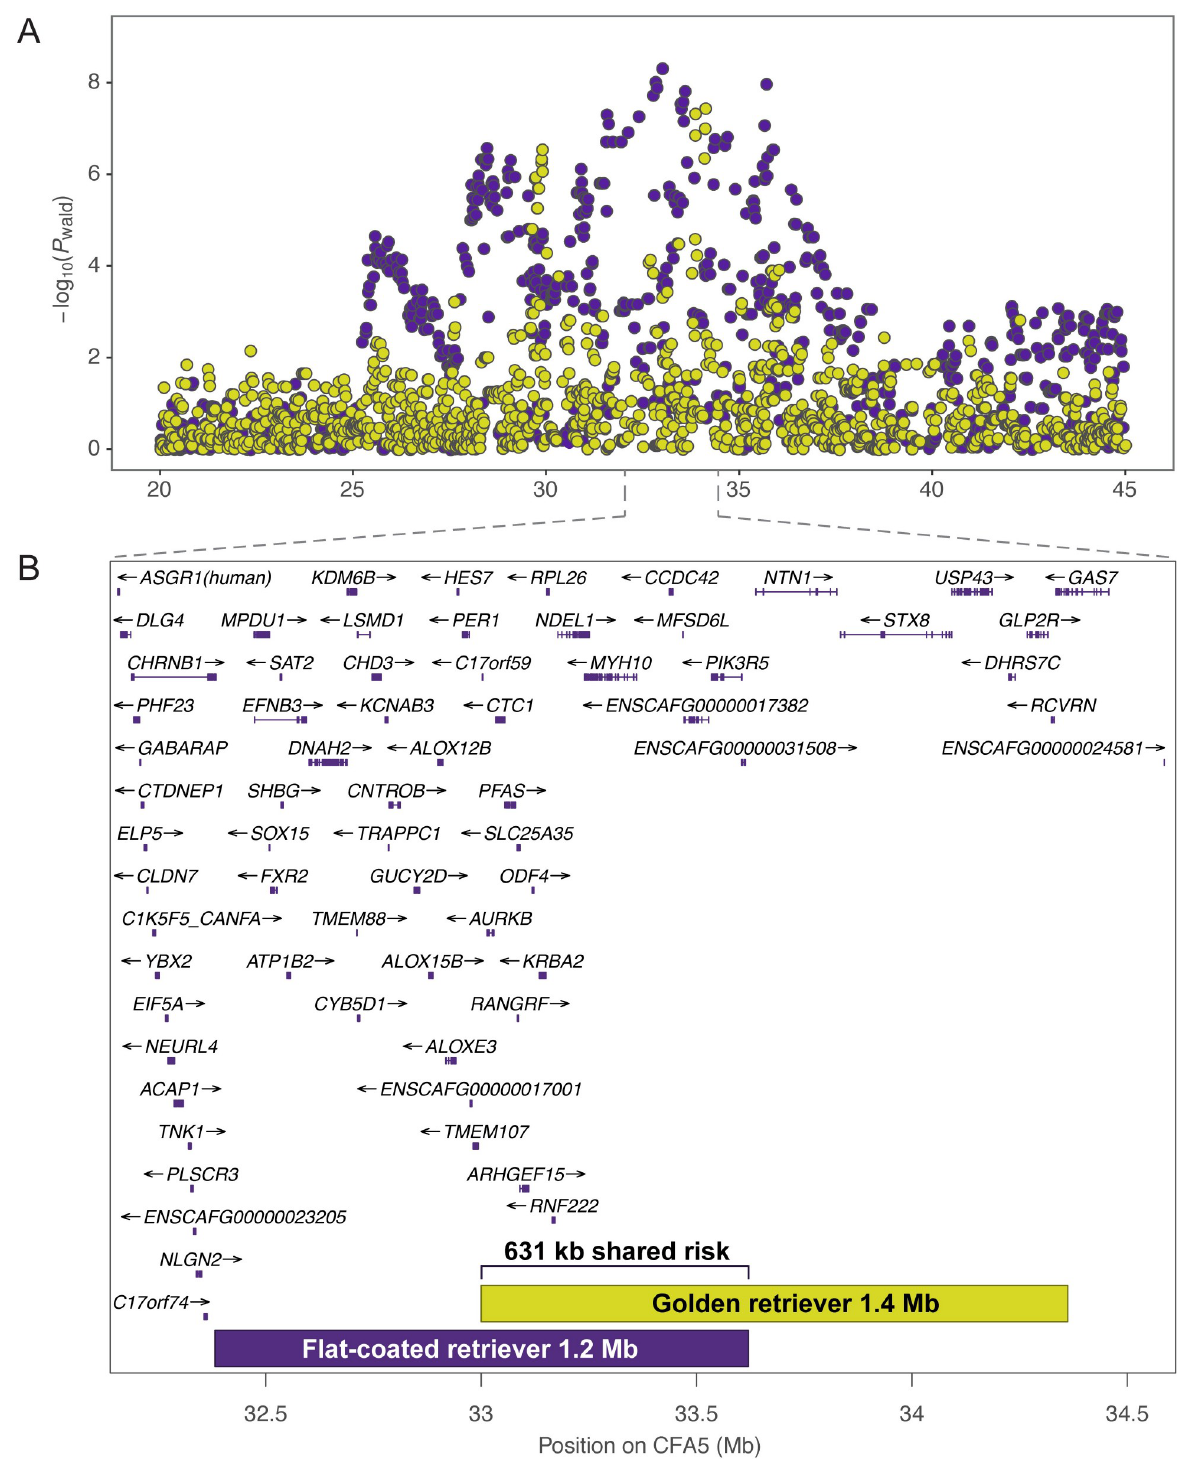
Fig 4. Colocalization of FCR histiocytic sarcoma CFA5 locus with golden retriever hematological malignancy loci. A) Regional Manhattan plot showing FCR histiocytic sarcoma GWAS SNPs in purple. Results of a combined golden retriever GWAS with 142 hemangiosarcoma, 41 B-cell lymphoma, and 172 controls are overlaid in gold. The peaks at 29 Mb and 33 Mb (CanFam3.1) in golden retrievers correspond to hemangiosarcoma and B-cell lymphoma risk, respectively. B) Regions harboring risk haplotypes identified independently in FCRs (purple) with histiocytic sarcoma and golden retrievers (gold) with B-cell lymphoma are plotted with genes in the region. The risk haplotypes overlap for a shared 631 kb span (bracket).